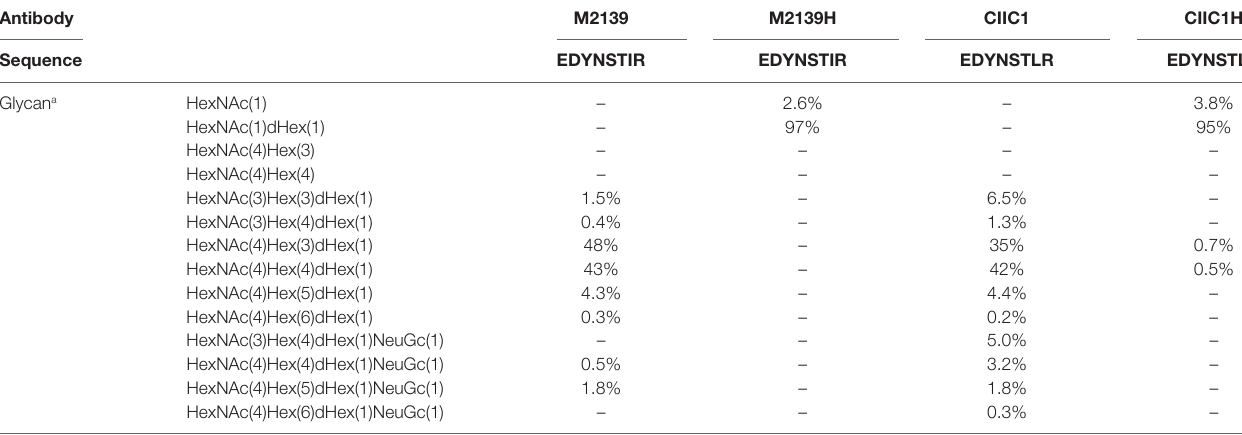
TaBle 1 | IgG glycoforms before and after endo- β - N -acetylglucosaminidase (EndoS) hydrolyzation. antibody sequence Glycan a